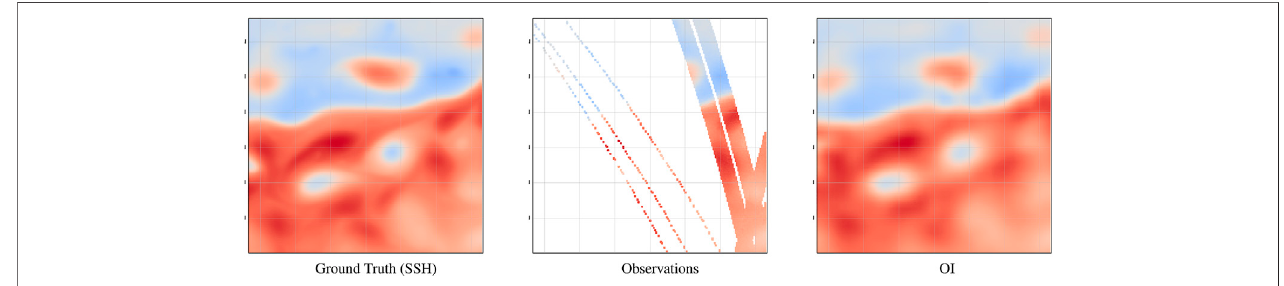
FIGURE 7 | Illustration of the considered SSH dataset on April 8th, 2013: from left to right, reference SSH fi eld (groundtruth), satellite-derived observation data (nadir along-track data and SWOT data), and optimally interpolated fi eld (OI).